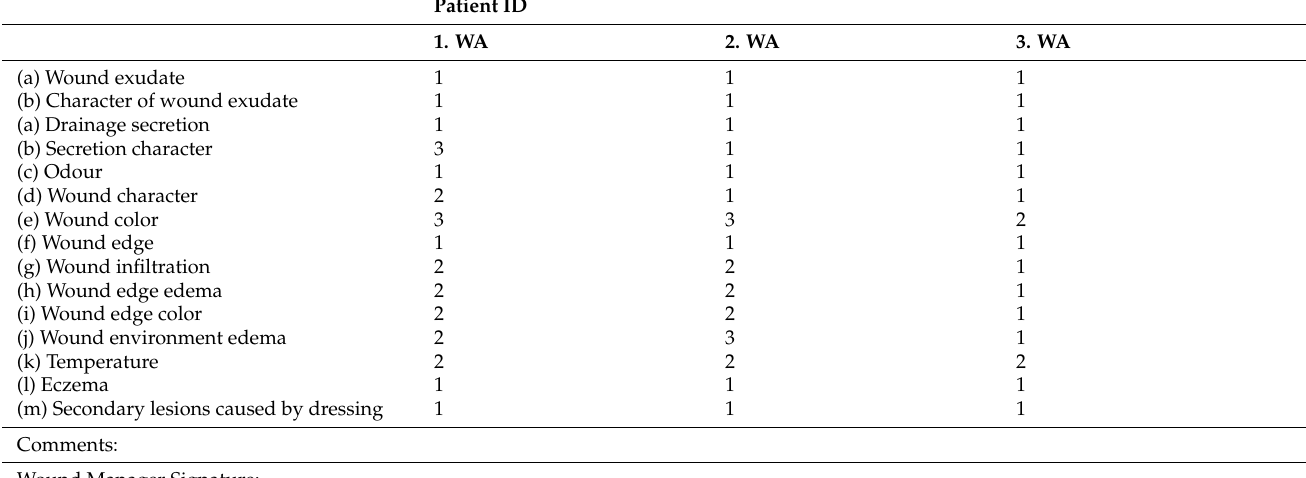
Table 2. Wound assessment (WA) chart and numerical scores for observation of wound exudate, wound character, wound edge and wound surrounding. (a) Wound exudate: 1 none/minimal, 2 moderate, 3 excessive exudates; (b) Character of wound exudate: 1 no secretion, 2 sanguinous, 3 serous, 4 haemoserous, 5 purulent; (c) Odor: 1 none/normal 2 malodor; (d) Wound character: 1 primary, 2 predominantly primary, 3 large defects/wound healing disorder, 4 predominant de- fects/wound healing disorders. (e) Wound color: pink tissue (epithelializing), red (granulating), yellow (fibrinous/sloughy), black (necrotic) 1 pink, 2 pink-red, 3 red, 4 red-yellow, 5 yellow, 6 black-yellow-red, 7 black-yellow, 8 black; (f) Wound edge color: 1 normal, 2 cyanotic, 3 red, 4 pale; (g) Wound infiltration: 1 normal, 2 soft, 3 hard; (h) Wound edge edema: 1 little/none, 2 moderate, 3 excessive; (i) Wound edge color: 1 normal, 2 cyanotic, 3 pale, 4 red (infection, erysipelas, phlegmon); (j) Wound environment edema: 1 normal, 2 local, 3 generalised; (k) Temperature: 1 normal, 2 slightly warm, 3 excessively warm; (l) Eczema: 1 none, 2 slight irritation, 3 allergy, 4 congestions; (m) Secondary lesions caused by dressing: 1 none, 2 blisters, 3